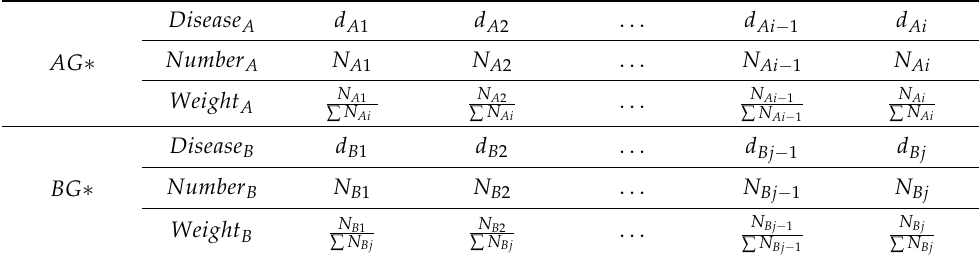
Table 1. Number of patients and corresponding weights for AG ∗ and BG ∗